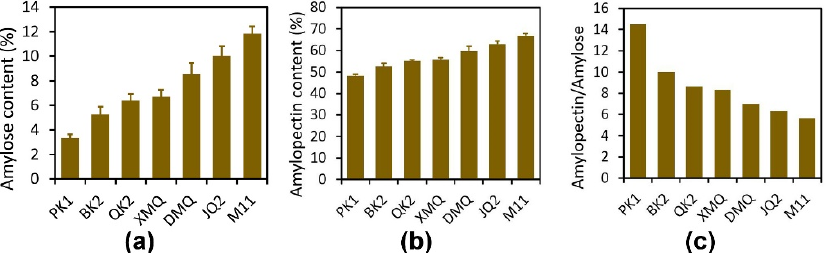
Figure 1. Starch content in late-filling-stage seeds of seven Tartary buckwheat varieties. ( a ) amylose content; ( b ) amylopectin content; ( c ) amylopectin/amylose. The data represent the mean ± SD that came from three biological replicates and at least two technical replicates for each biological replicate.